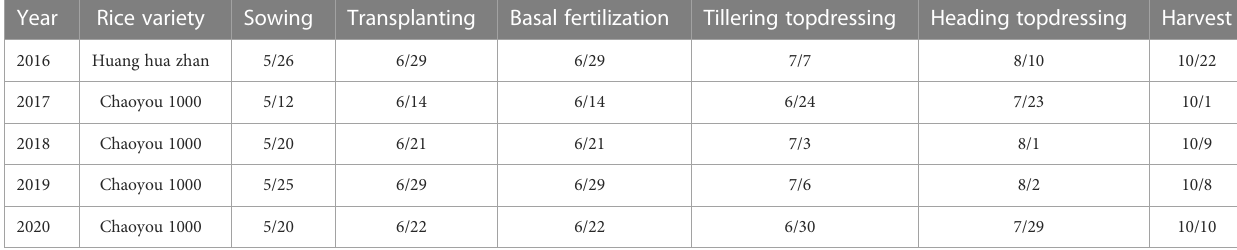
TABLE 1 Rice variety and timing of the planting and management operations.